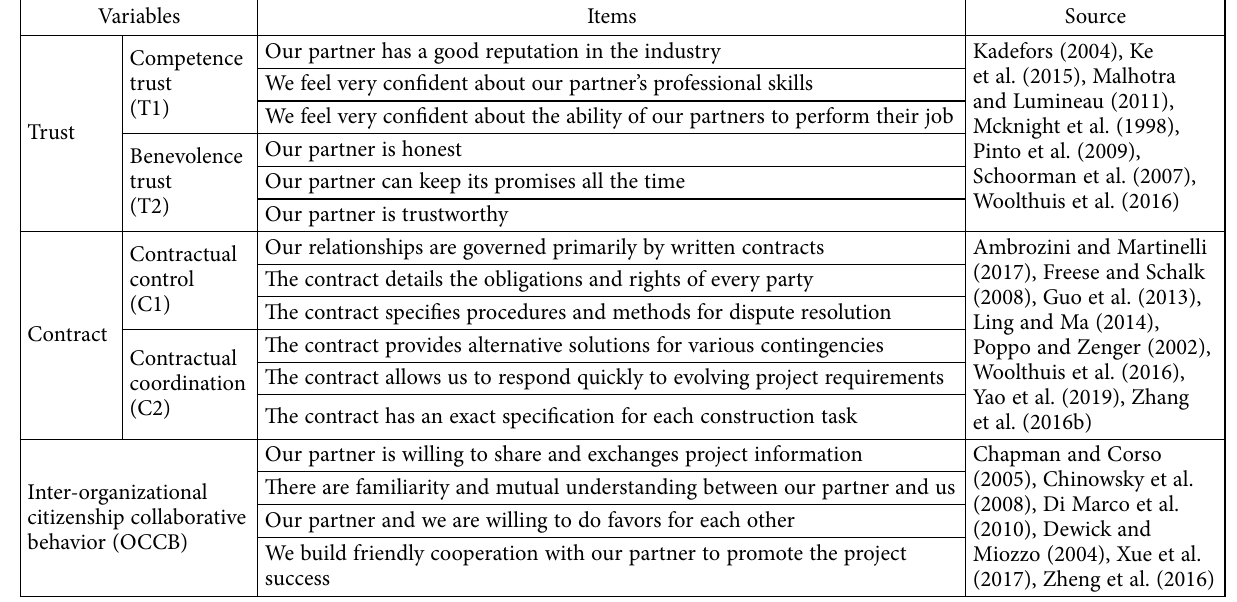
Table 1. Measurement items for trust, contract, and OCCB